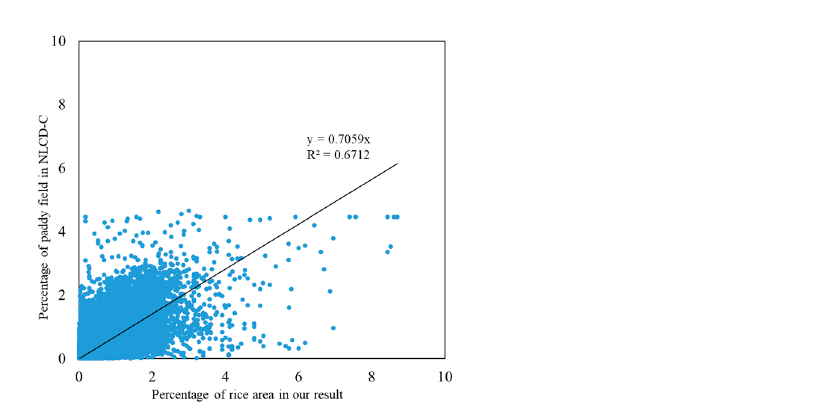
Figure 5. Comparison of rice area from our results and paddy fields extracted from the NLCD-C.